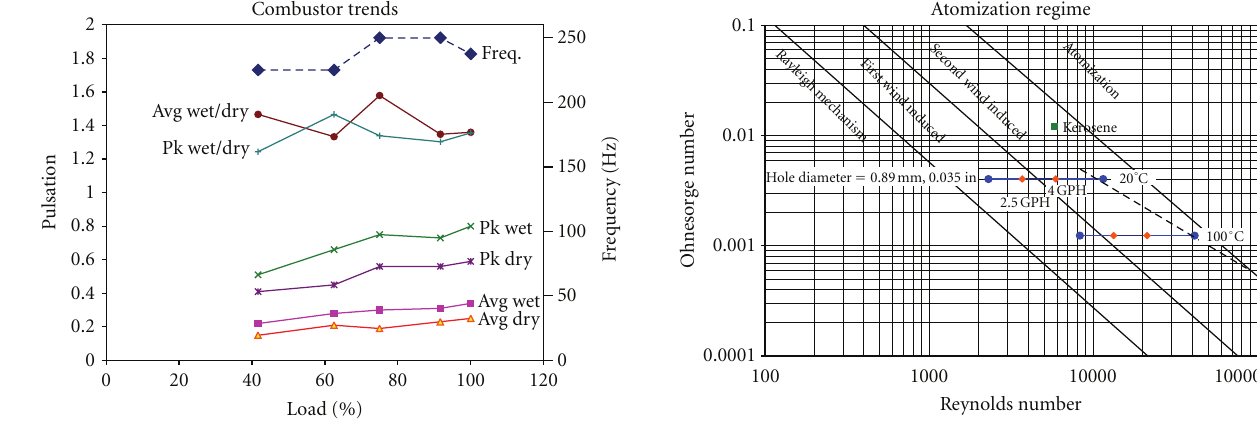
Figure 3: Trend of 250 Hz combustor pulsation versus load.